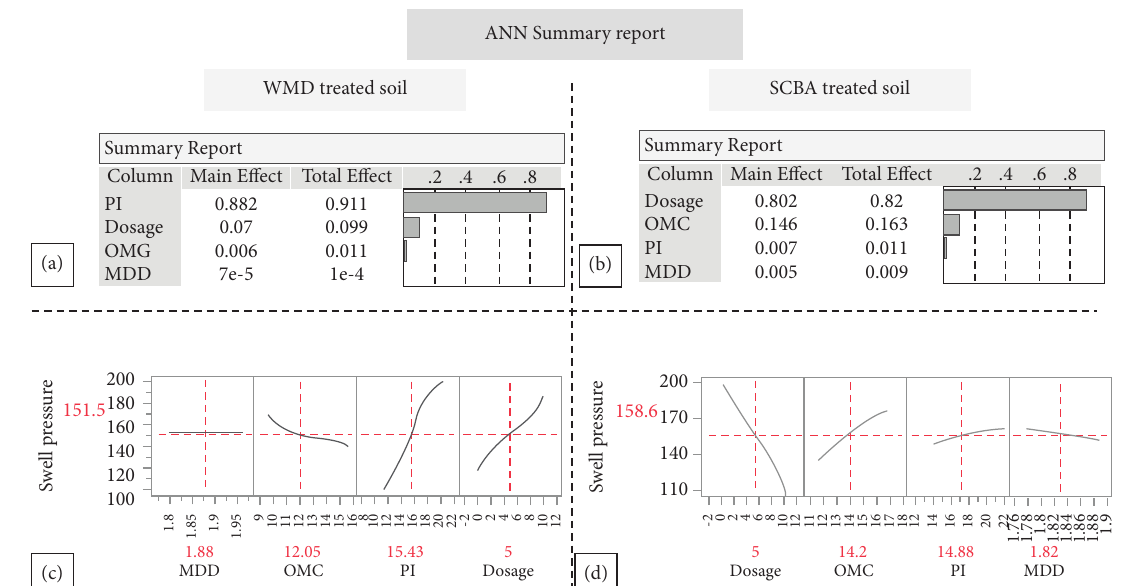
Figure 11: ANN-based sensitivity analyses of variable importance (a, b) and variable combined impact (c, d), for WMD-treated samples and SCBA-treated samples, respectively.